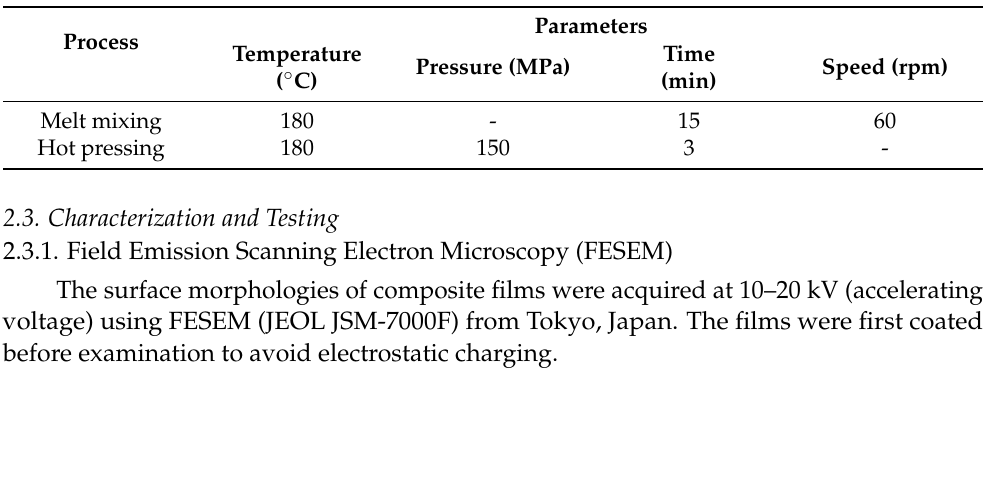
Table 2. Fabrication Process